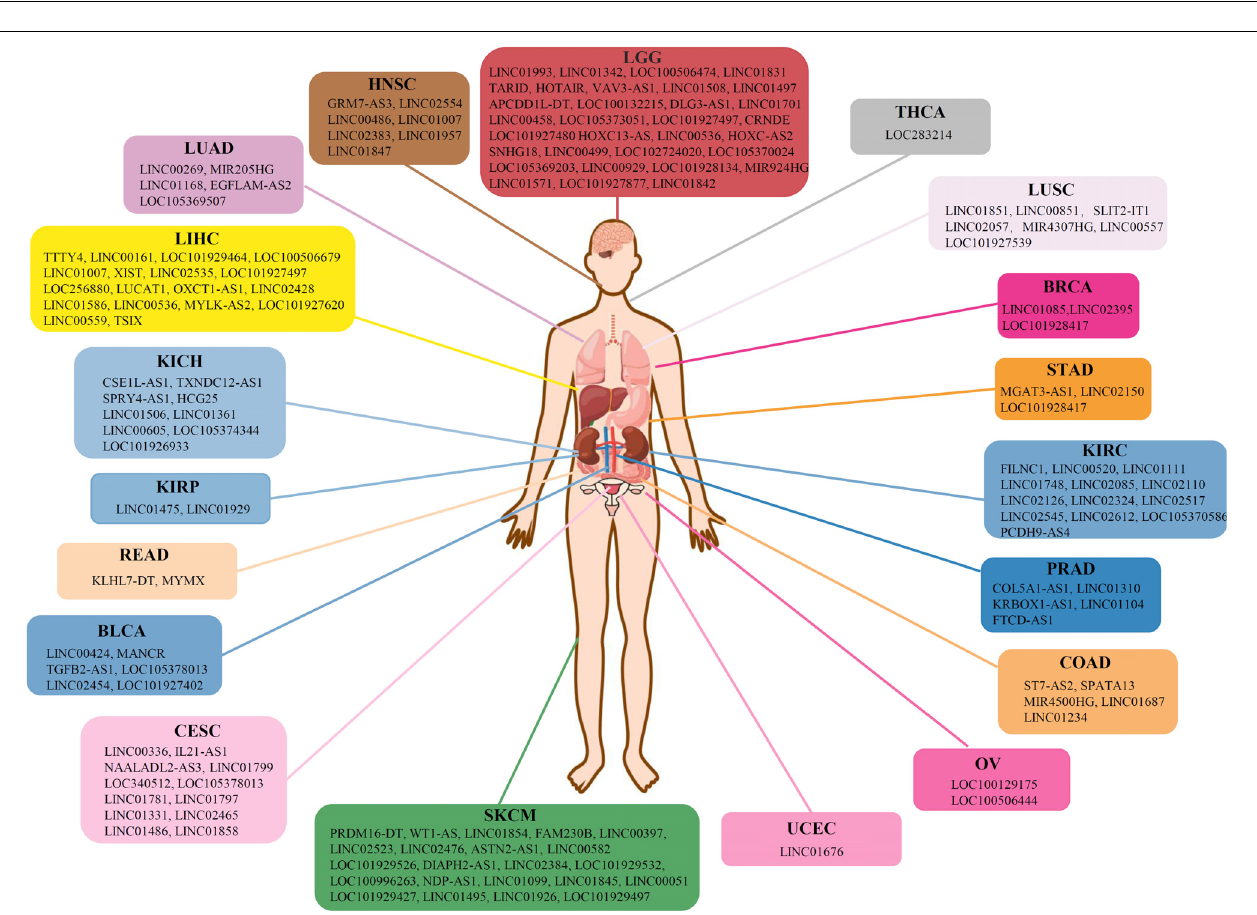
FIGURE 3 | Distribution patterns of top-ranking ncRNA markers on associated cancer types. The x-axis represents the top 20 miRNA markers and lncRNA markers divided by a blue dotted line. Y-axis represents 19 cancer types in nine cancer categories. Each grid marked with orange colors represents the ncRNA markers were associated with the corresponding cancers.